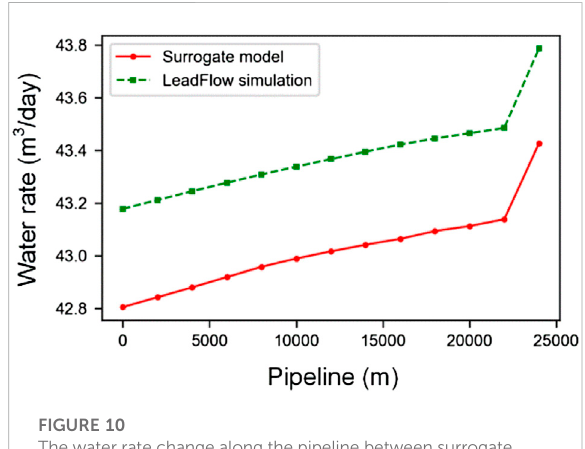
FIGURE 8 The change of gas rate along the pipeline between surrogate mode and LeadFlow simulation.